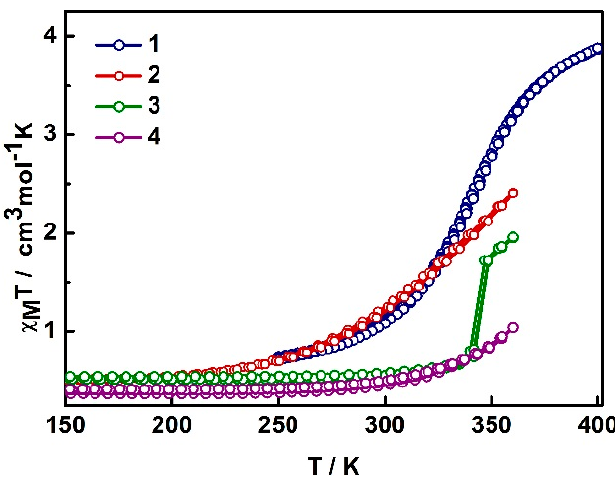
Figure 1. Variable-temperature magnetic susceptibility ( χ M T ) measurements for compounds 1 – 4 .